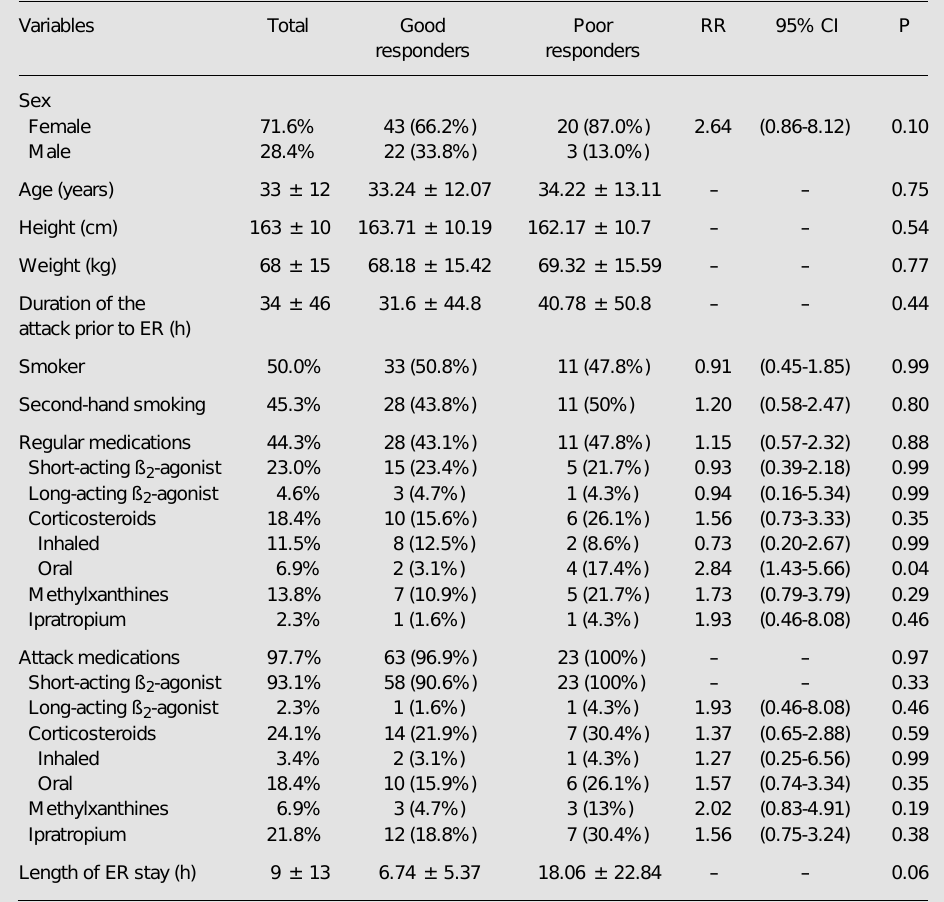
Table 1. Demographic